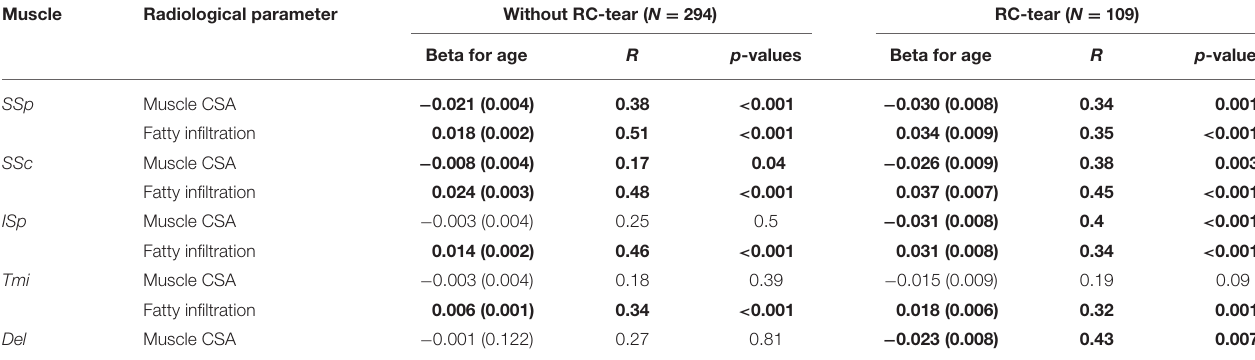
TABLE 3 | Age-associated analyses of muscle cross sectional area and fatty infiltration in five muscles of subjects without RC-tear and in RC-tear. Muscle Radiological parameter Without RC-tear ( N = 294 ) RC-tear ( N = 109